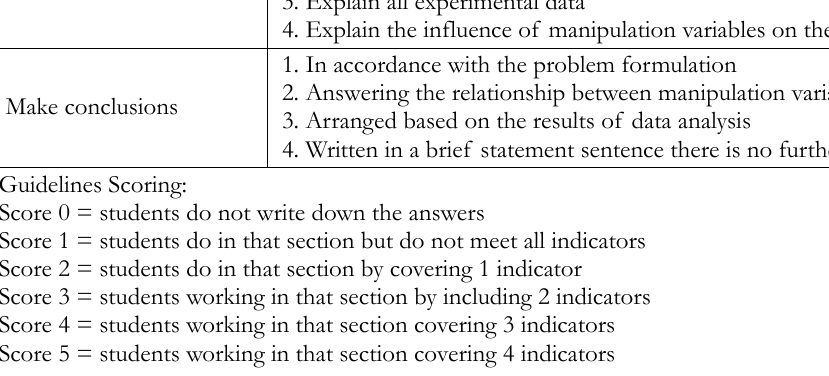
Table 2. Rubric for assessing student science process skills on the extraction project report